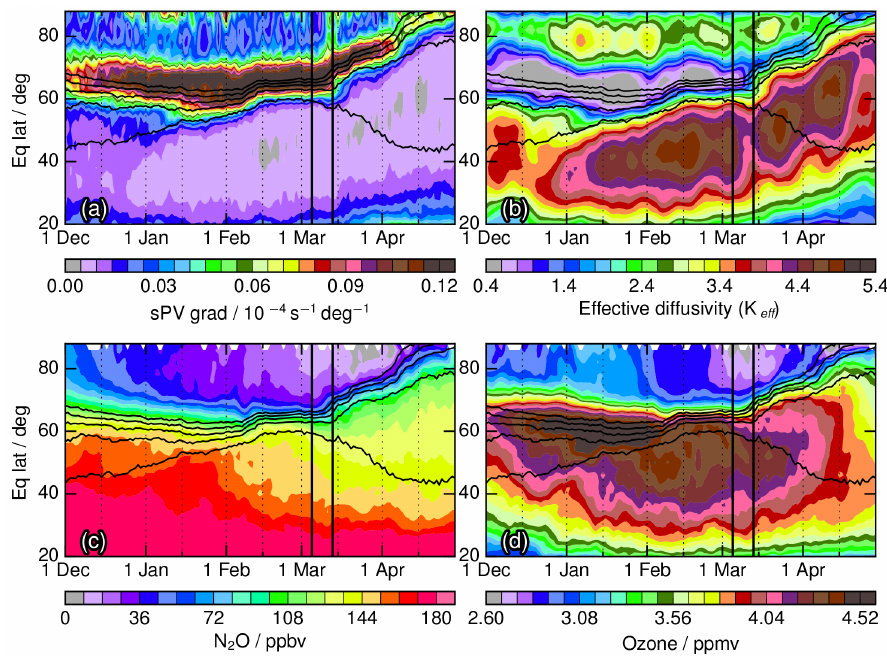
Figure 7. Equivalent latitude–time series at 550K for 2015/16 as in Fig. 6 but showing only sPV gradients (a) , K eff (b) , N 2 O (c) , and ozone (d)